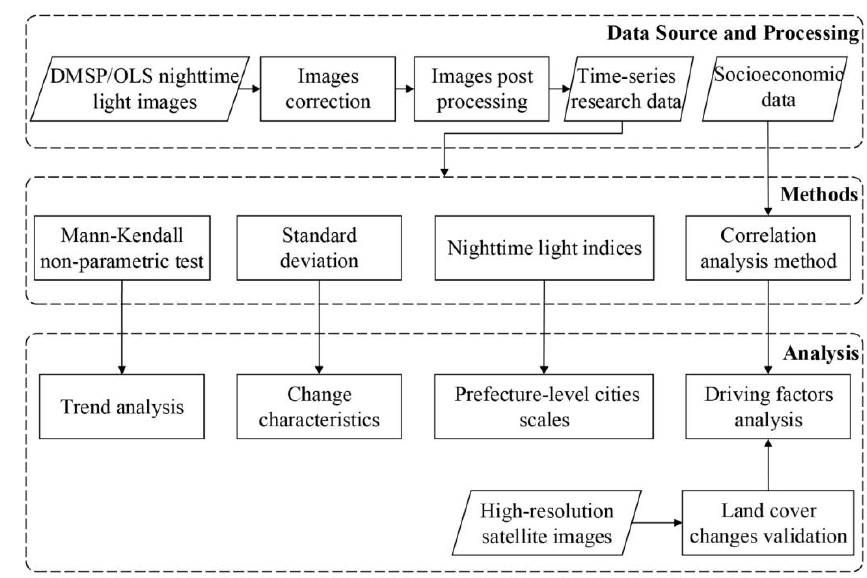
Figure 2. Flowchart of methodology for investigation of the characteristics and driving factors of artificial lighting in the Beijing-Tianjin-Hebei region.